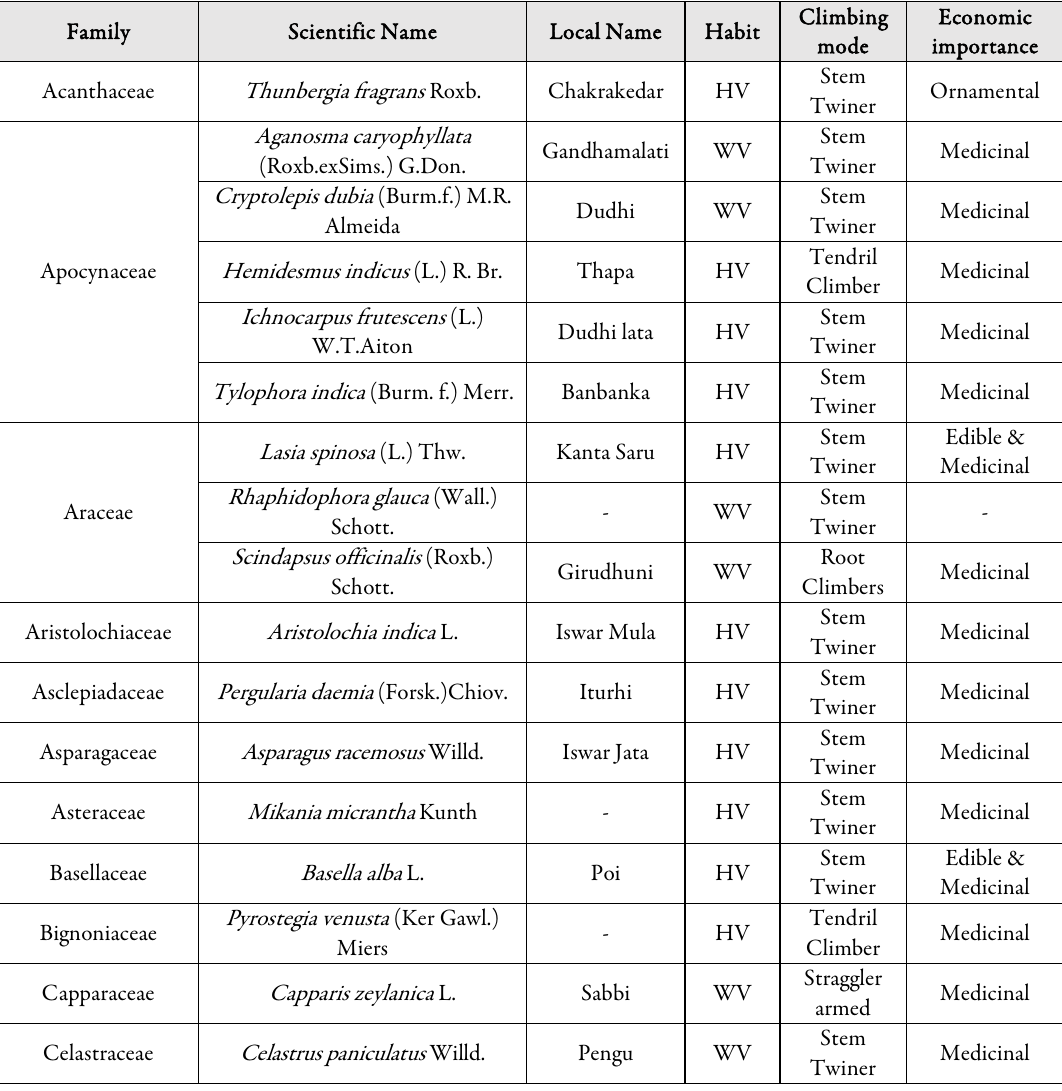
Table 1. List of climbers in SBR, Odisha, India